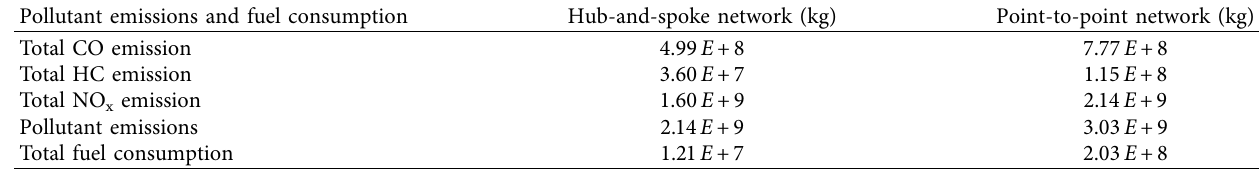
Table 8: Contrast of pollutant emissions and fuel